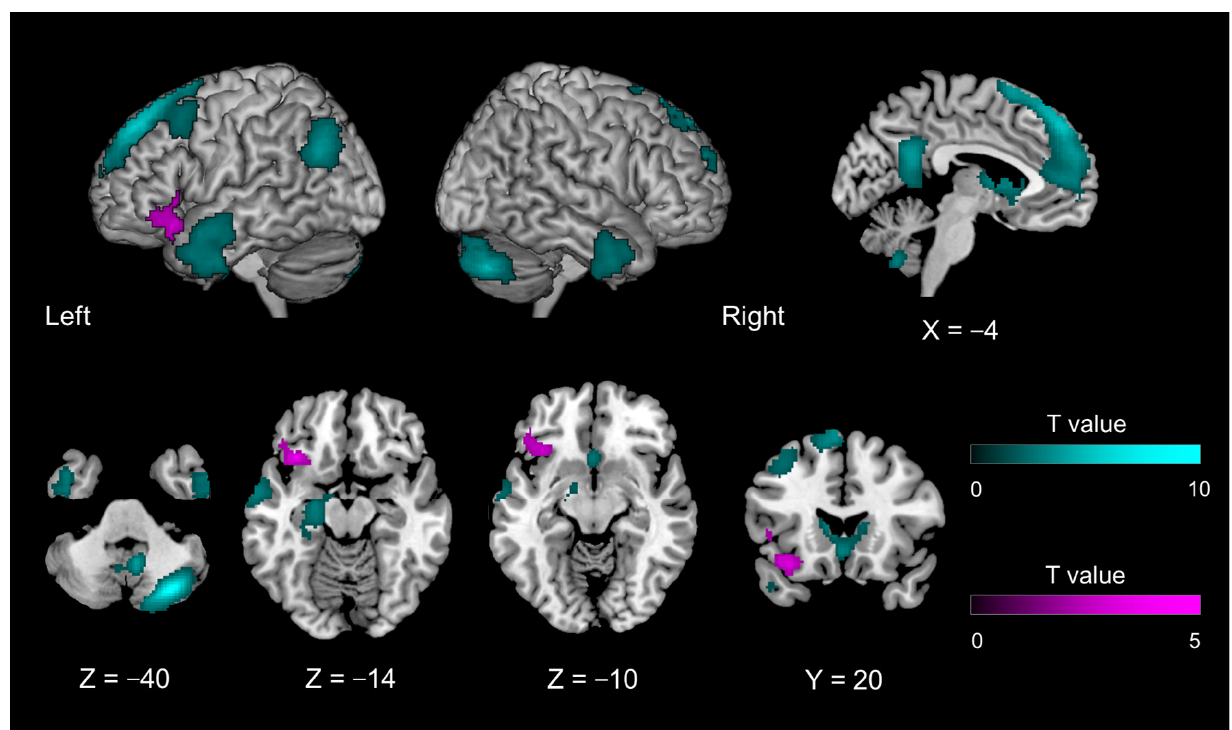
Figure 3. Brain activity during the disclosure phase of introspection relative to object feature identification, irrespective of mismatch and match conditions (Contrast #11, Table 1) (cyan region); and introspection-specific mismatch as compared with object feature identification-related mismatch (Contrast #12, Table 1) (magenta